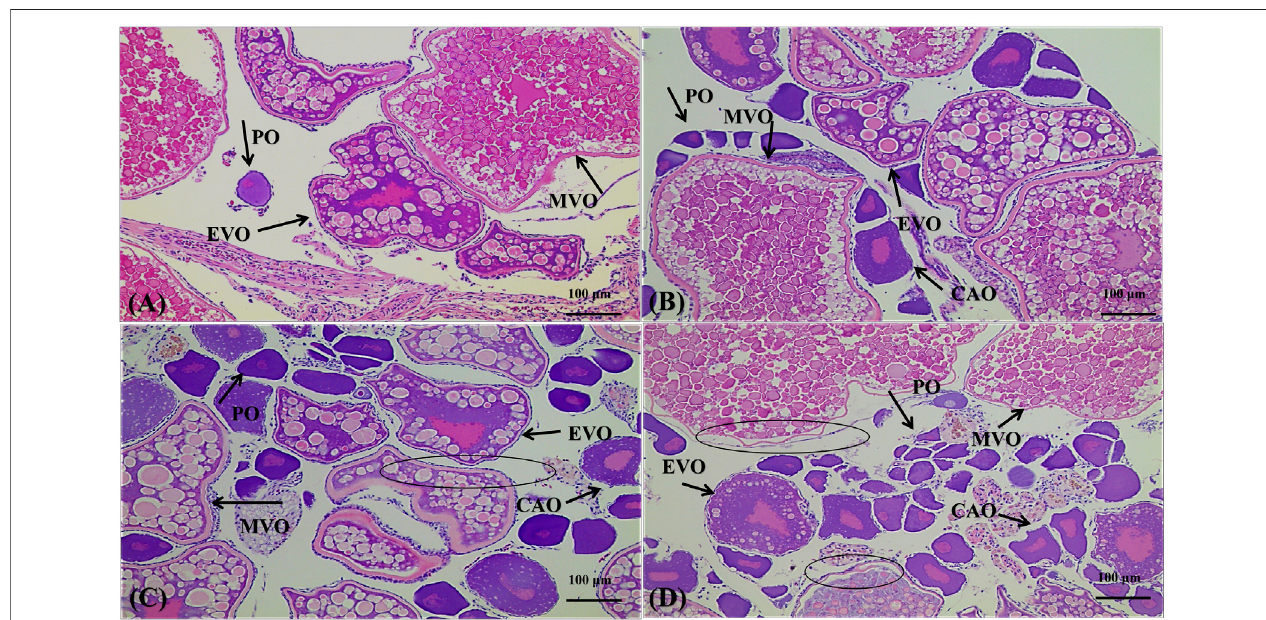
FIGURE 7 | Effects of 4,4 ′ -di-CDE exposure on histology of the ovary of zebra fi sh after 14 days of exposure. (A) Ovary from the control, showing normal ovarian structure with developmental stages of the oocytes. (B) Ovary from 1 μ g/L group, exhibiting the number of PO and CAO increase; (C) and (D) ovary from 10 to 50 μ g/L groups not only shows the number of POand CAO increasing but also the loss of contacts between the oocyte cell membranes (ellipse).PO, peri-nuclear oocyte; CAO, cortical alveolar oocyte; EVO, early vitellogenic oocyte; MVO, mid-late vitellogenic oocyte.